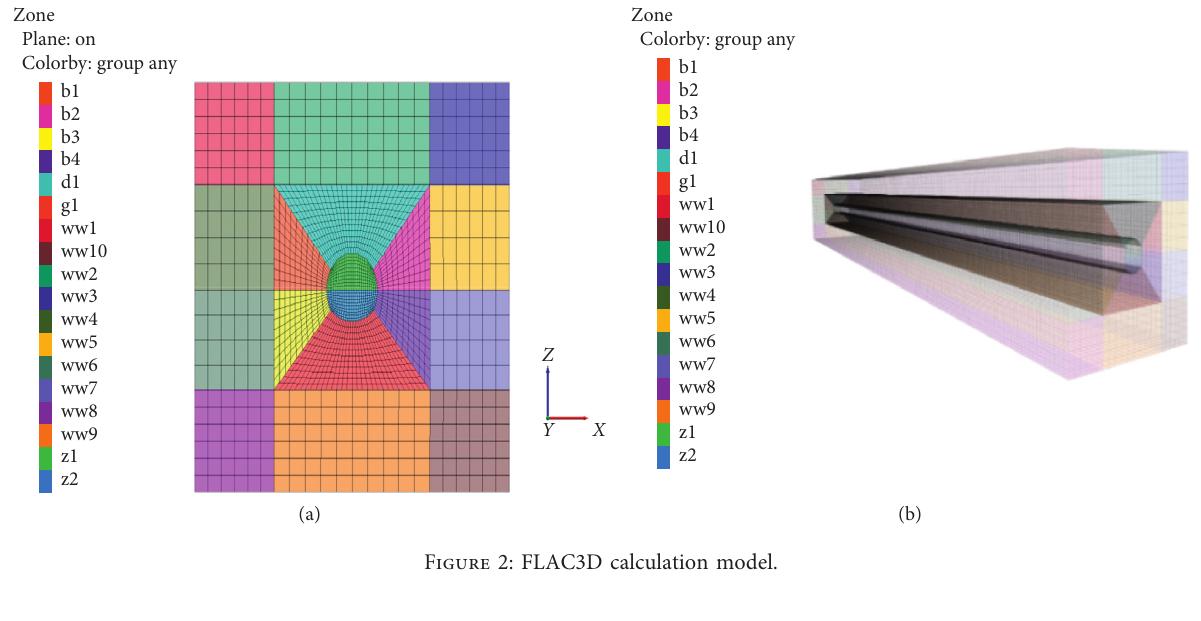
Figure 2: FLAC3D calculation model.